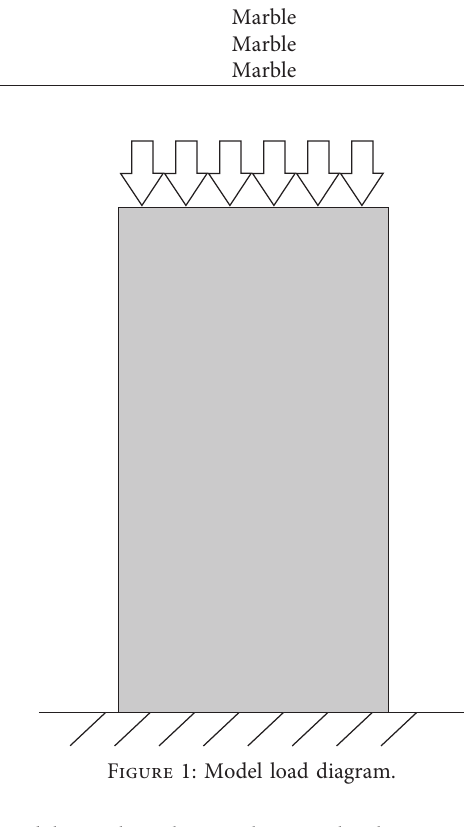
Figure 1: Model load diagram.